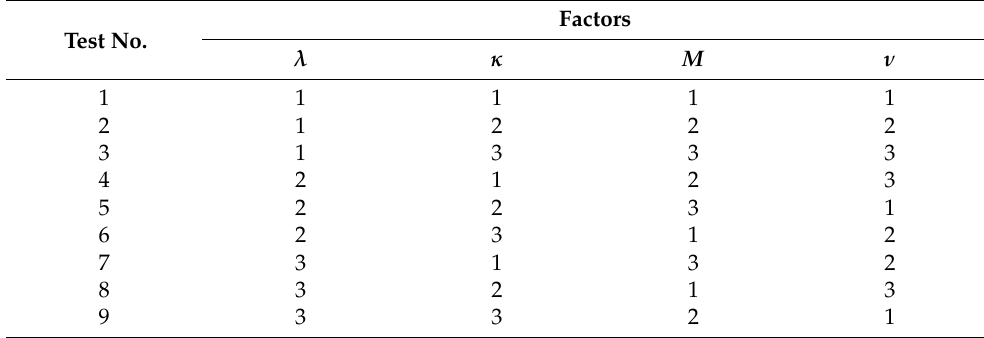
Table 3. L 9 (3 4 ) orthogonal test